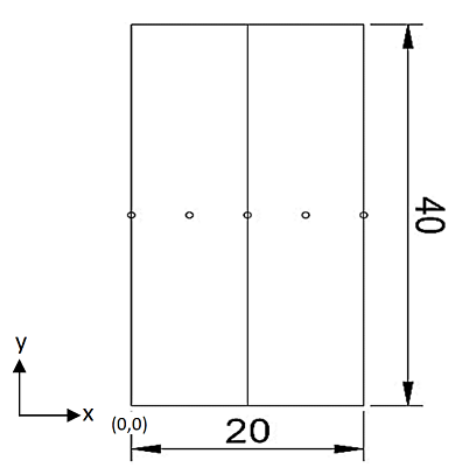
Figure 10. Boundary temperature probe points perpendicular to weld line (x-axis).